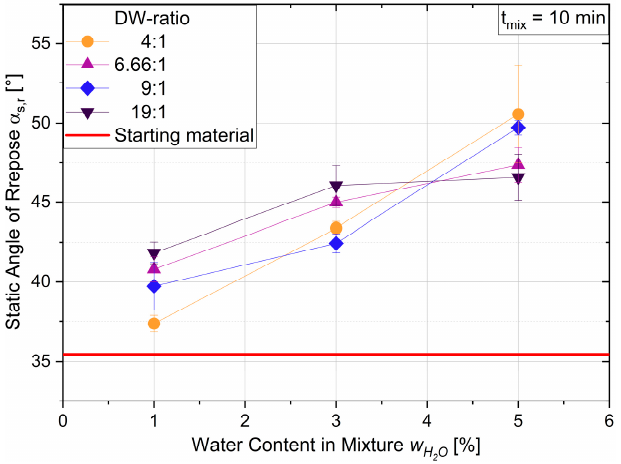
Figure 16. Static angle of repose in dependence of the water content w H2O for mixtures containing different dry water variants.